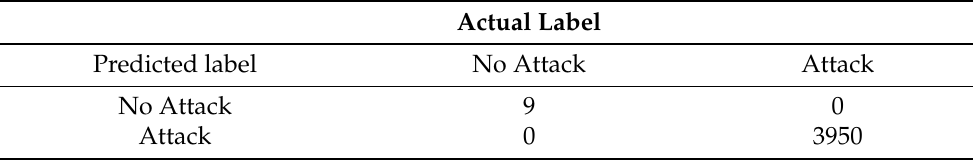
Table 13. DDoS HTTP DT confusion